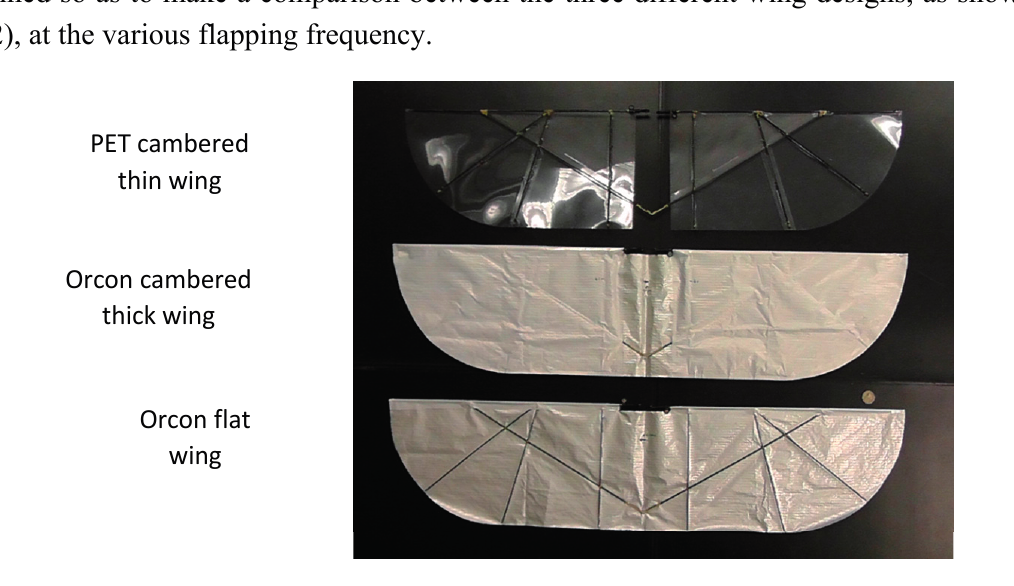
Figure 32. Three different wing designs (bottom